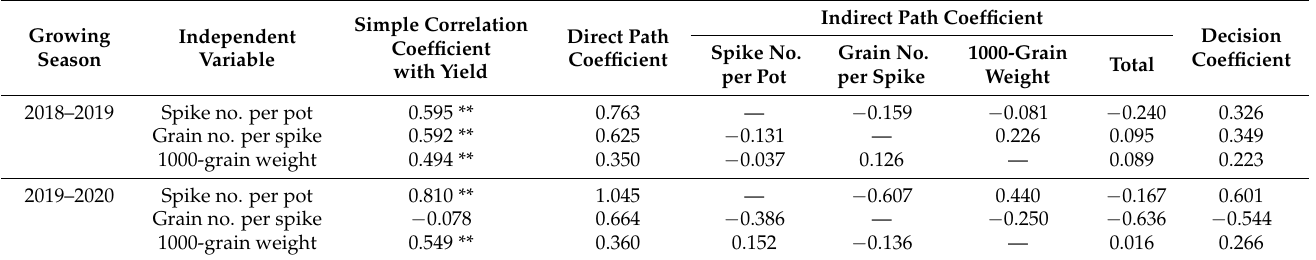
Table 3. Simple correlation coefficient decomposition between yield and yield